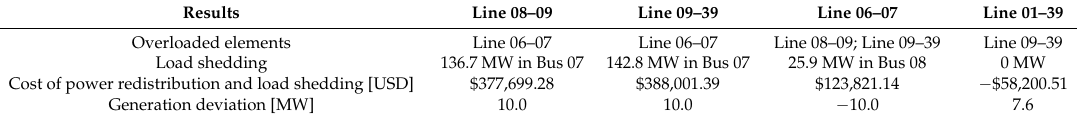
Table 4. Results after a contingency that considers the outage of line 05–08.